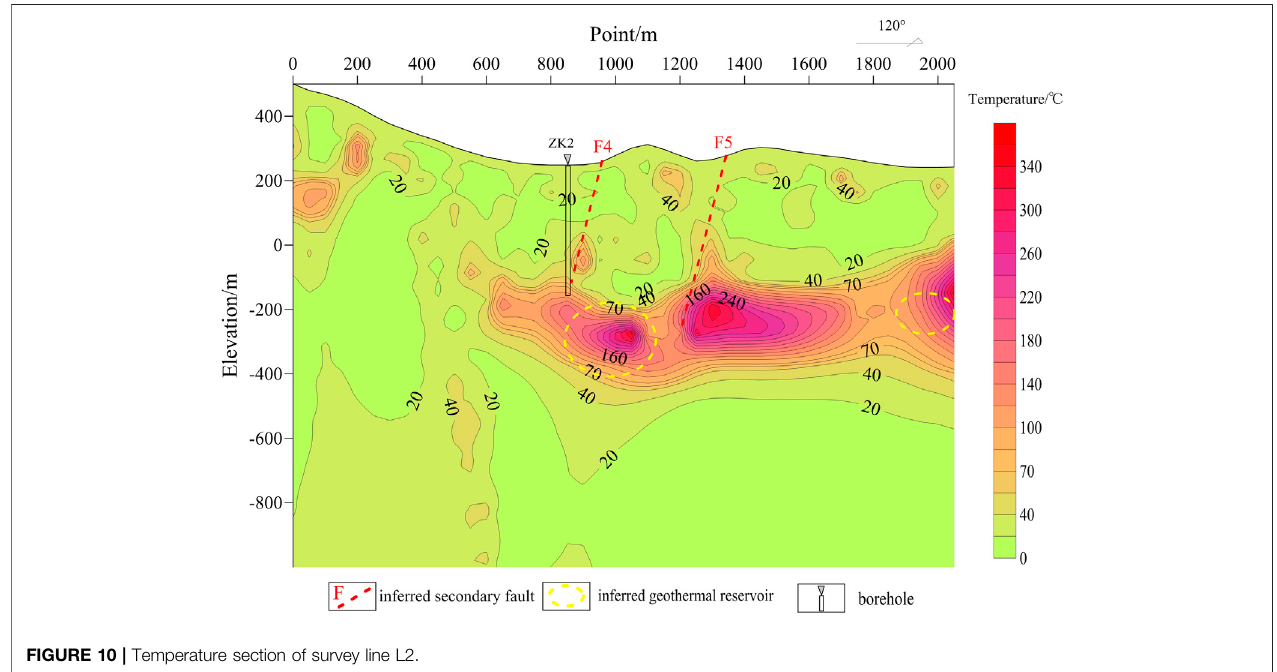
FIGURE 10 | Temperature section of survey line L2.